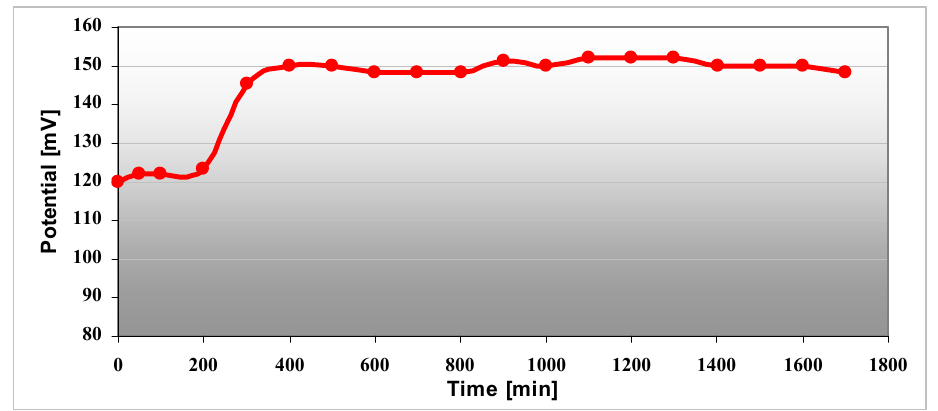
Figure 14. pH sensor diagram, voltage versus time in pH 7 buffer solution.